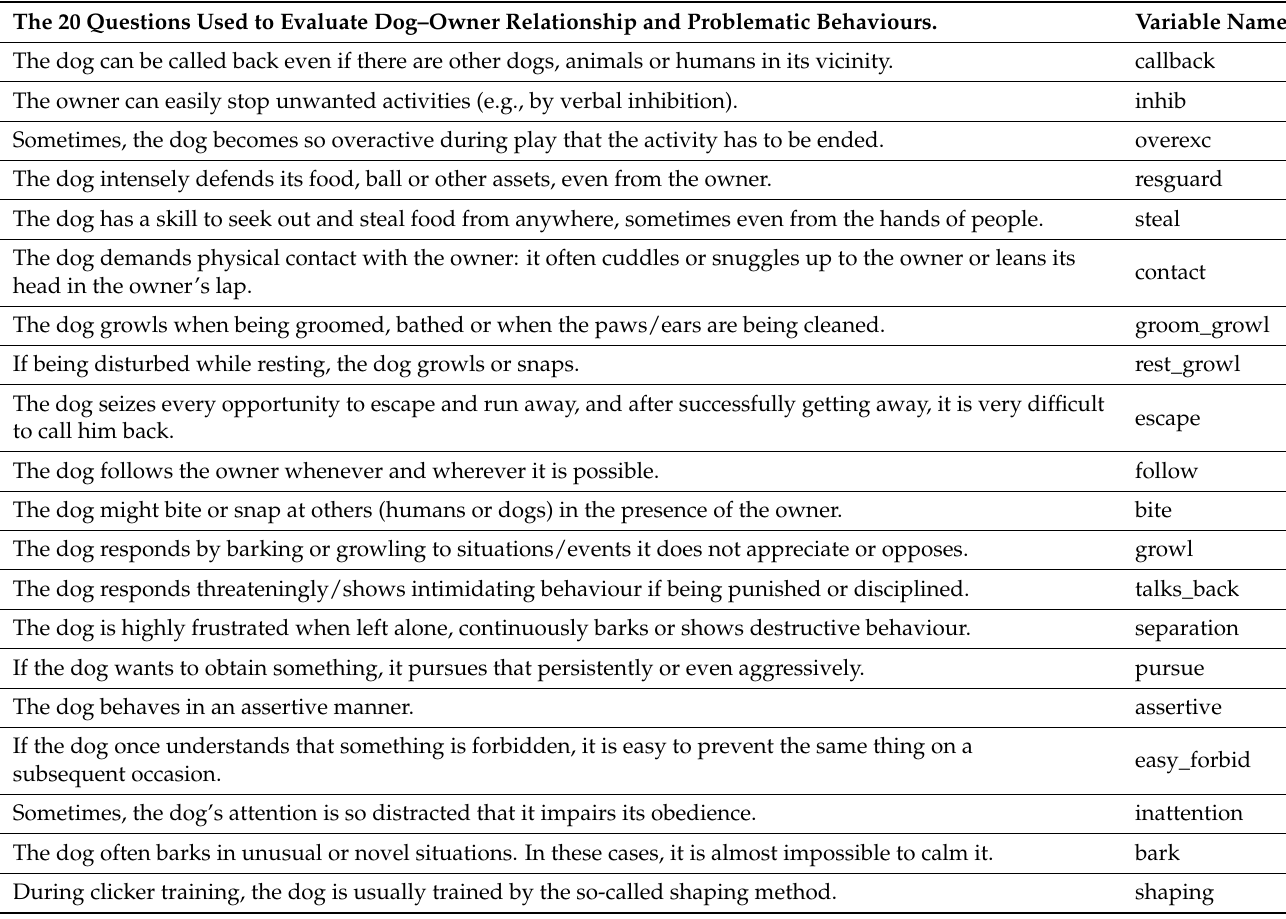
Table 1. The questionnaire used in the